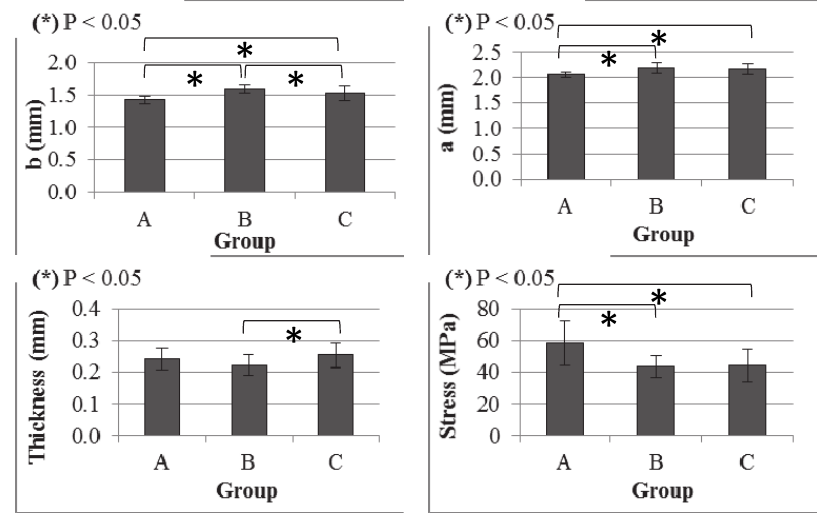
Figure 4: Comparative results in terms of bone morphology and mechanical strength. The lengths of the minor axis (b), of the major axis (a), of cortical shell thickness and of ultimate stress are